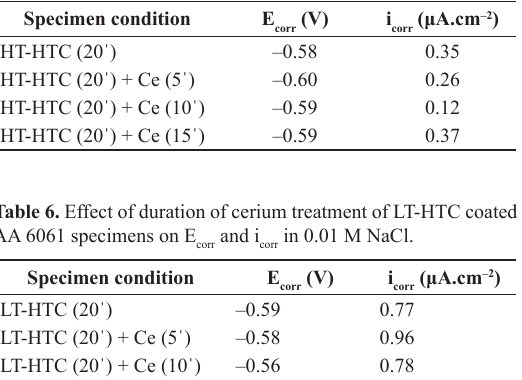
Table 5. Effect of duration of cerium treatment of HT-HTC coated AA 6061 specimens on E Specimen condition